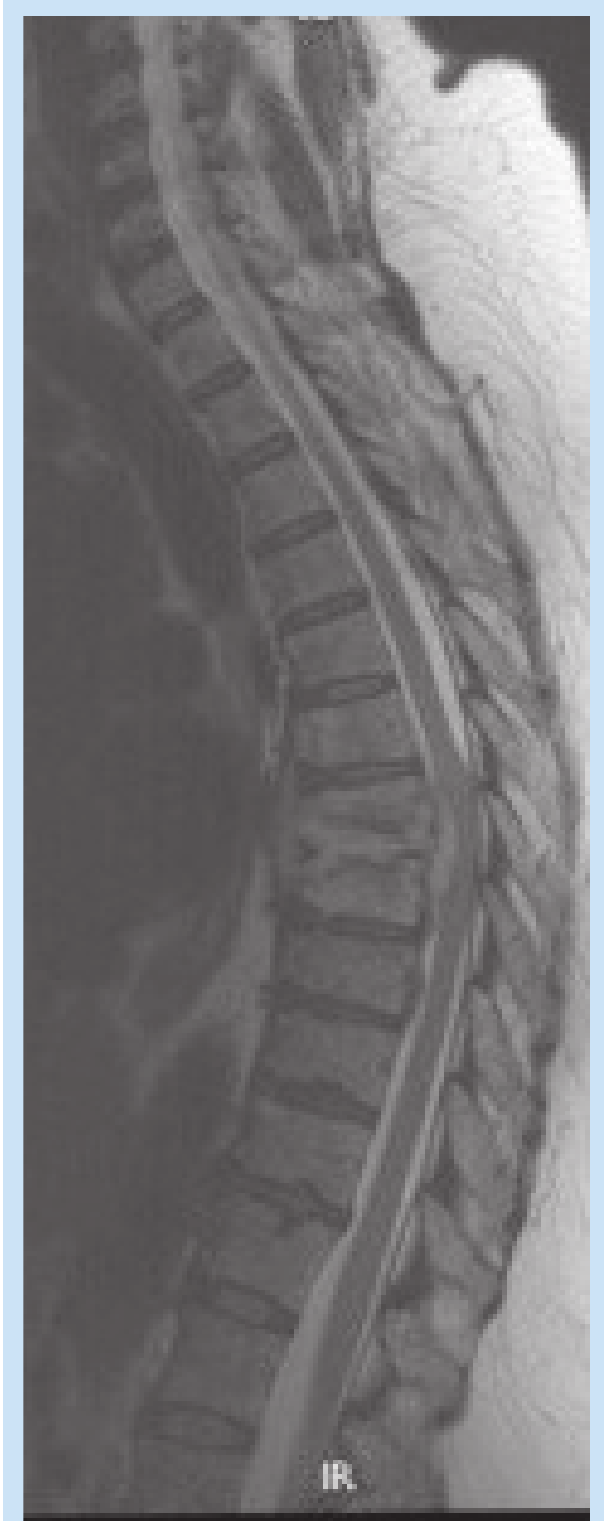
Fig 3b. T2 sagittal image. High signal in affected